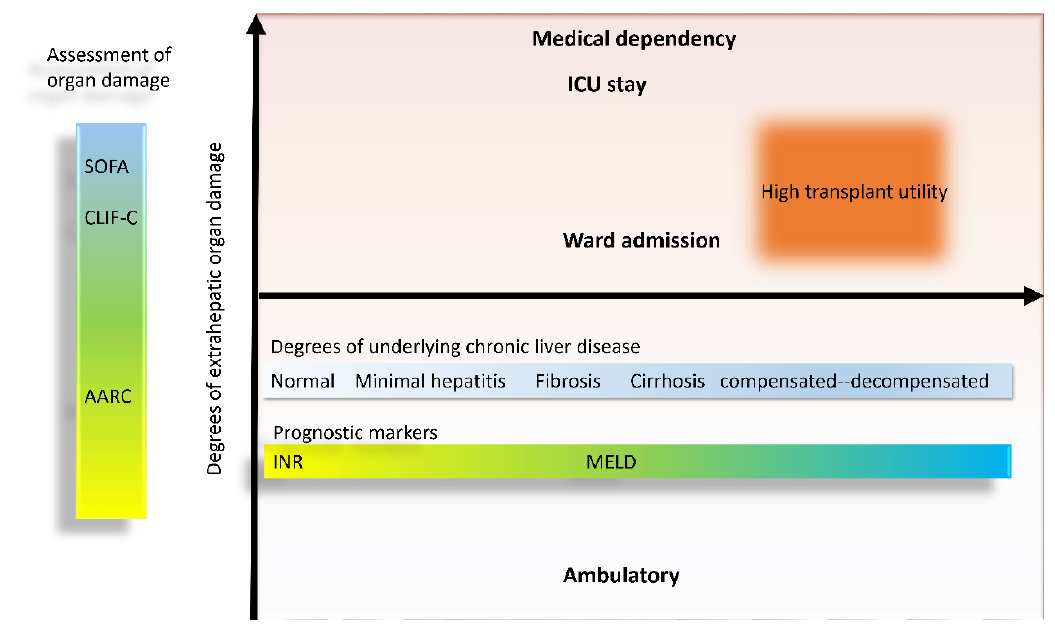
Figure 4. Proposed dynamic model of prognostication and transplant utility in acute-on-chronic liver failure. CLIF-C, European Foundation for the Study of Chronic Liver Failure; ICU, intensive care unit; INR, international normalized ratio; MELD, Model for End-stage Liver Disease; SOFA, Sequential Organ Failure Assessment.